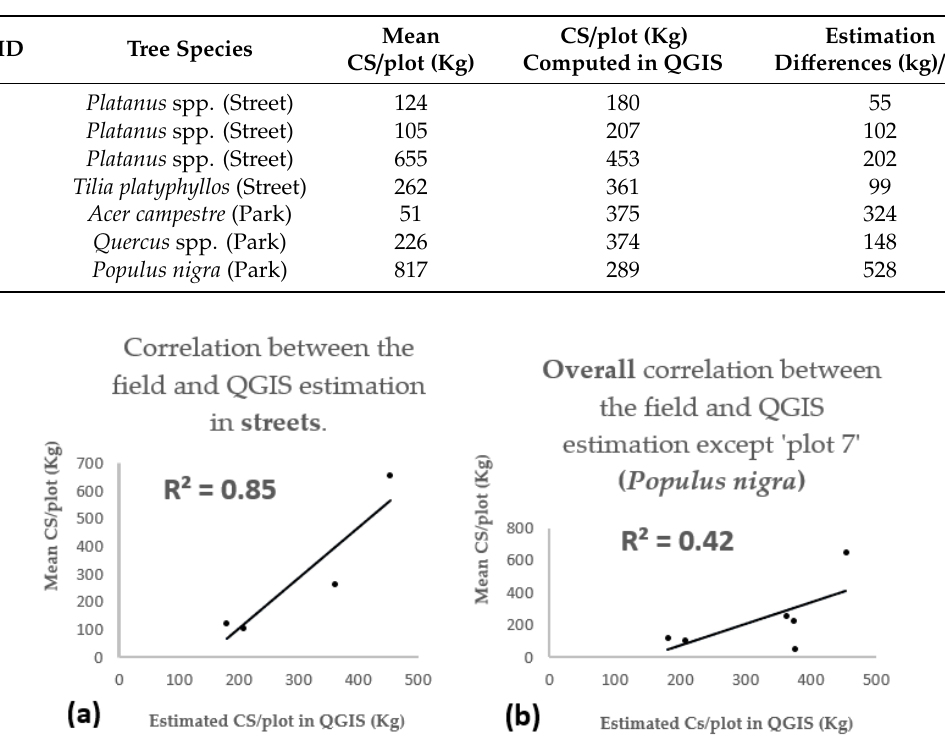
Table 5. The results obtained during the validation of the estimated CS in the validation plots.